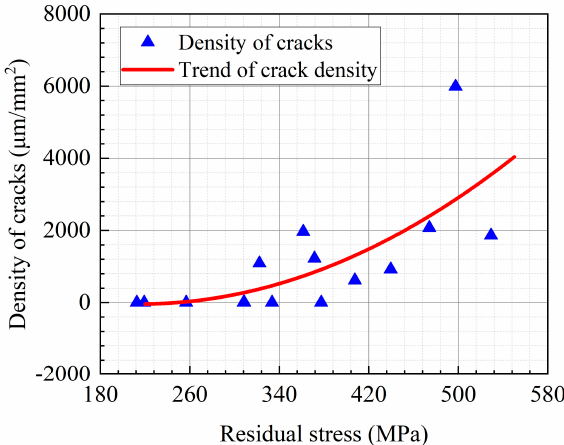
Figure 12. Correlation between crack density and residual stress in AISI 304 stainless steel.